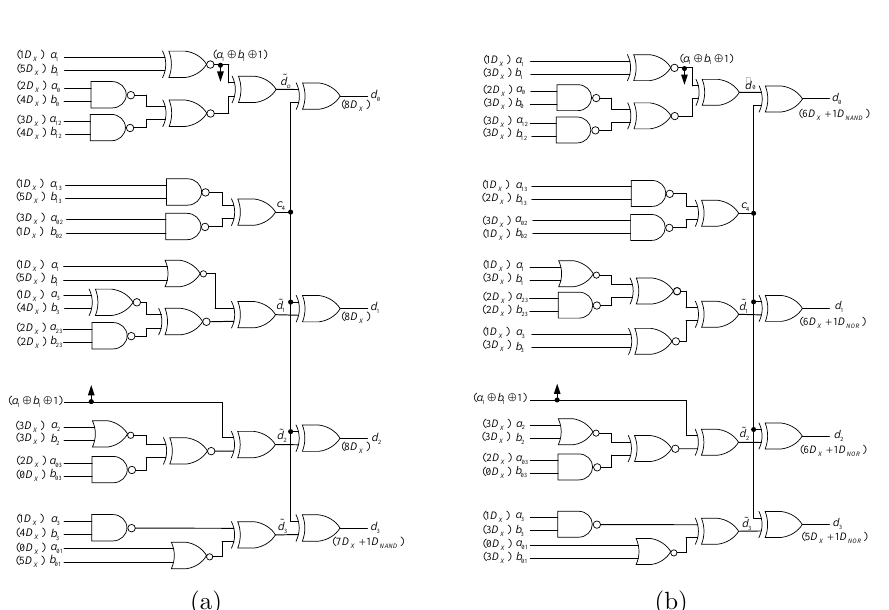
Figure 3: The proposed exponentiation computation block for the S-box architecture. (a) For the proposed lightweight S-box implementation (b) For the proposed fast S-box implementation. Note that the order of additions (XOR/XNOR) that generate d 1 is different between two